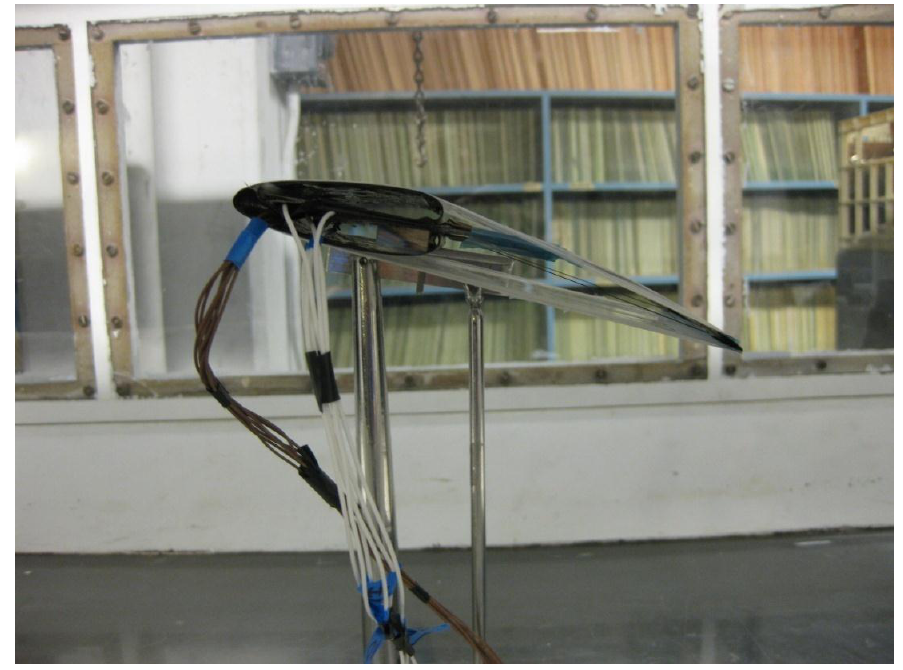
Figure 10. Side view of Airfoil in Wind Tunnel with a Tip Rotation of δ = 30°.